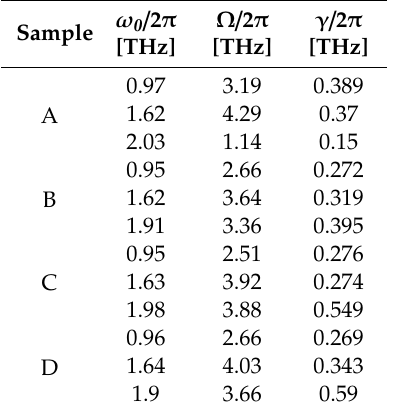
Figure 4. ( a ) Curve fittings for C 1 s core-levels of A, B, C, and D. ( b ) The relative intensity areas for the chemical state of the CH 3 NH 2 molecular defect. Table 1. The fitting results of collection of Lorentz